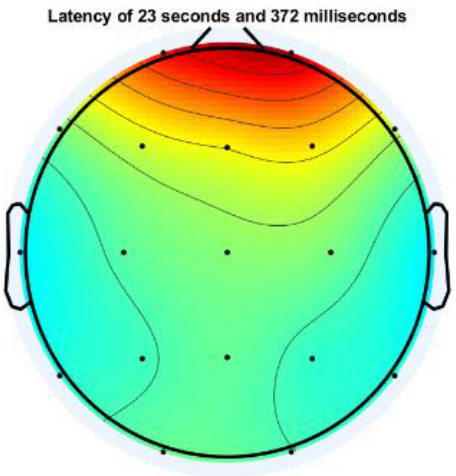
Figure 4. Topographic plot of one EEG channel contaminated with eye artifact.